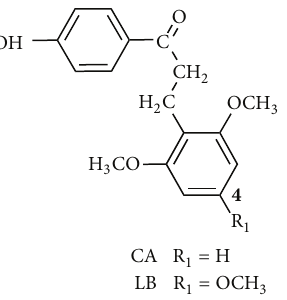
Figure 1: Molecular structures of Cochinchinenin A and Loureirin